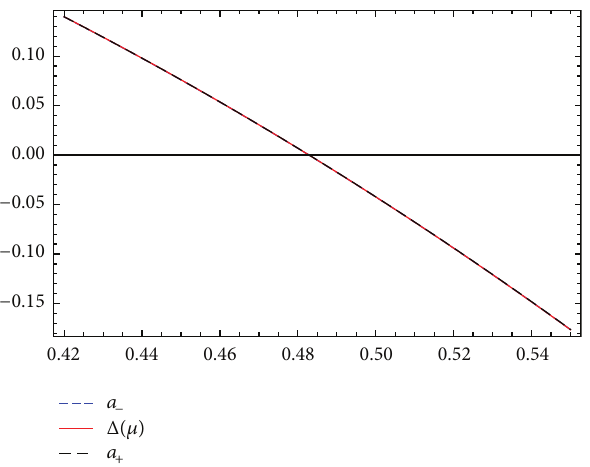
Figure 6: The enclosure interval dominating 𝜇 1 for 𝑚 = 14 , 𝑁 = 40 , 𝜃 = 1/26 , and 𝜀 = 10 −10 .